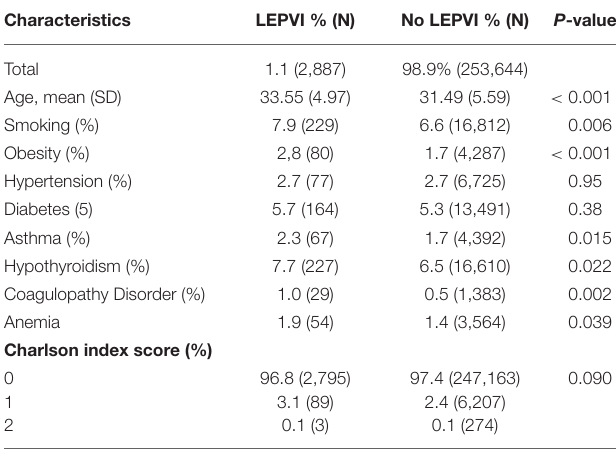
TABLE 2 | Prevalence estimates and OR with their 99.5% confidence intervals for loss of fetal well-being among pregnant women, Spain